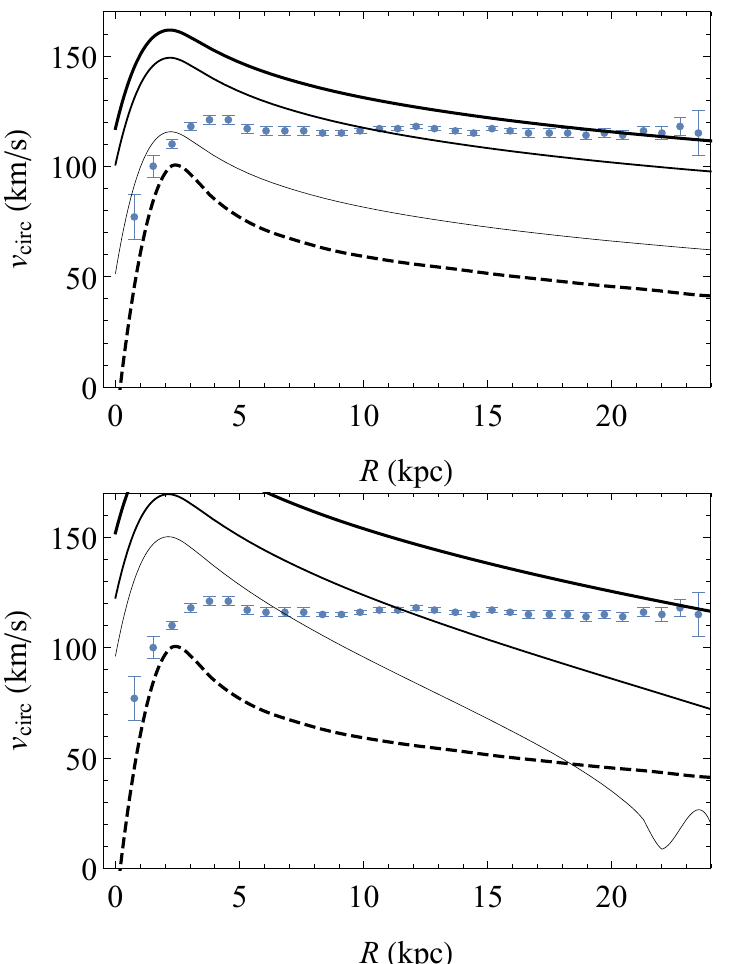
Figure 12 . Comparison of the data points of NGC6503 with the n = 0 rotation curve of the theory T with weighted derivatives in the extreme fractional regime with a data-based matter v density profile for α = 1 (Einstein’s theory, dashed curve), α = 0 . 90 , 0 . 82 , 0 . 80 (top panel, increasing thickness) or α = 2 / 3 and R = 3 , 5 , 10 kpc (bottom panel, increasing ∗